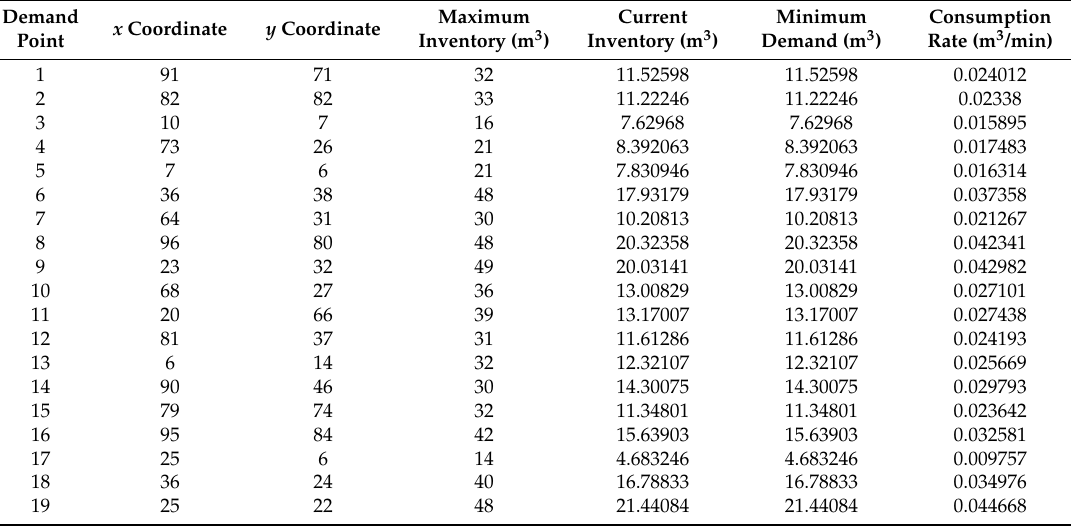
Table 3. Demand Information of gas